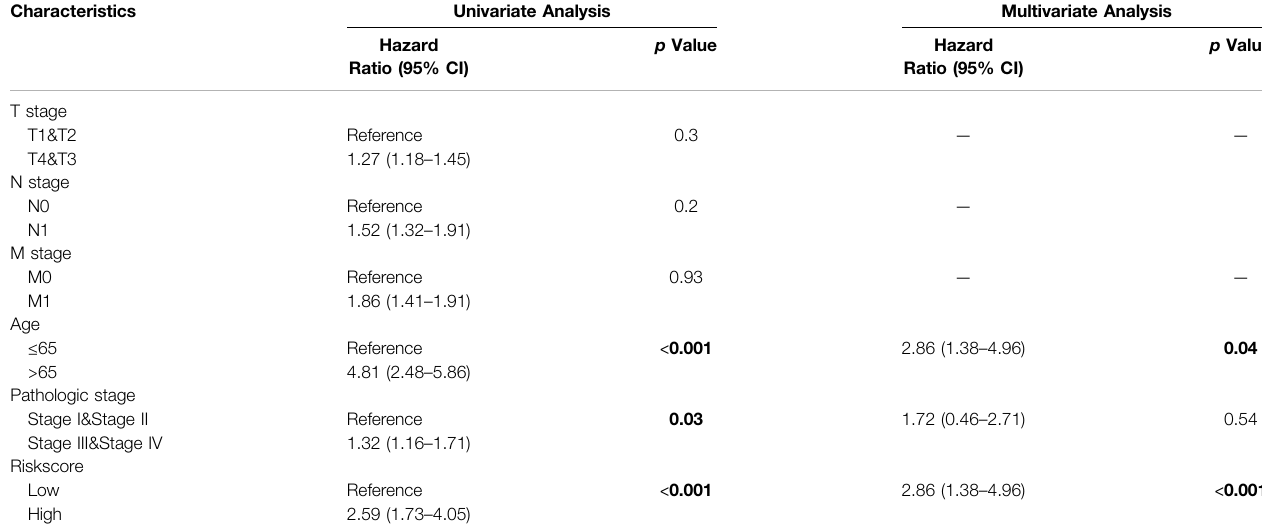
TABLE 3 | The model was found to be an independent factor affecting OS in patients with HCC in both univariate and multifactorial Cox regression analyses.